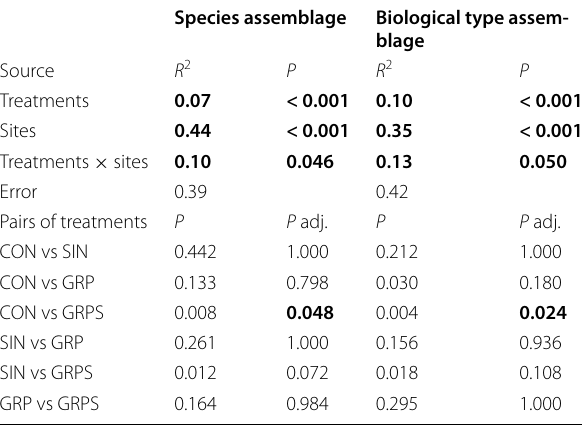
Results that are significant at α 0.05 are shown in bold = CON controls, SIN single-tree selection cut, GRP group-selection cut, GRPS group- selection cut with